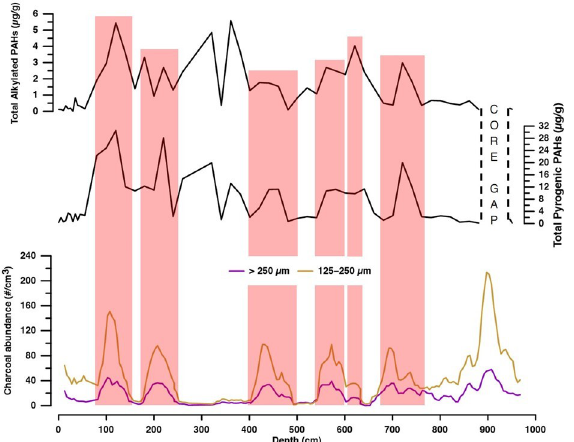
Fig 6. Depth variations in charcoal abundance with the total concentrations of pyrogenic parent and alkylated